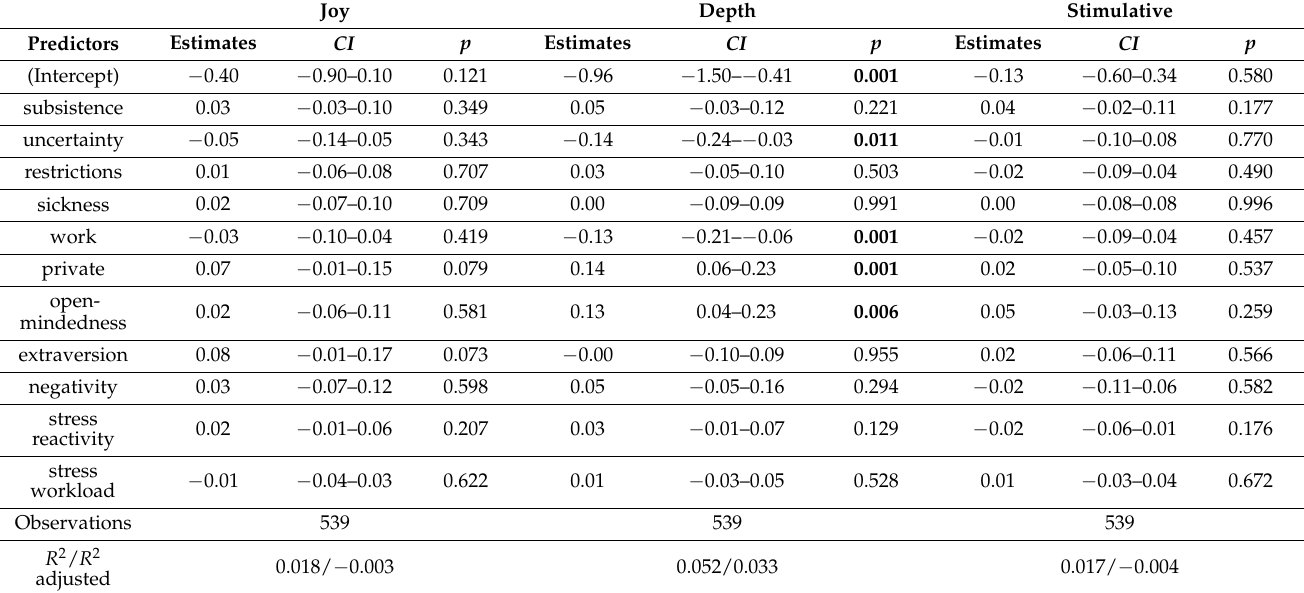
Table 7. Results of the linear models predicting changes in musical attributes. Joy Depth Stimulative